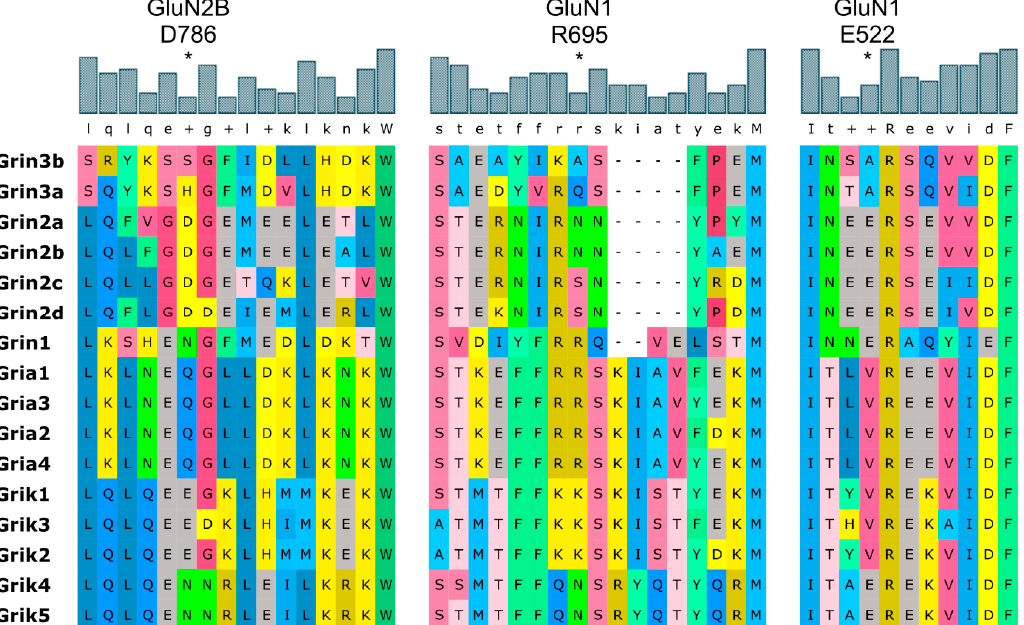
Figure 6. Summary of key LBD residues involved in the NMDAR structural transition between closed and open states. In the open state (and partially also in the RAA state) the Arg695 residue of the lower GluN1 LBD lobe (light blue) formed a double salt bridge with the Asp786 of the upper GluN2B LBD lobe (orange) and the Glu522 residue of the upper GluN1 LBD lobe (blue). In the closed state, however, the GluN1 Arg695 residue interacted only within the subunit with the Glu522 residue of the upper GluN1 LBD lobe (blue). The observed changes in the Asp–Arg–Glu salt bridges were related to the binding and unbinding of the negatively charged glutamate ligand to the GluN2B LBD binding cavity.